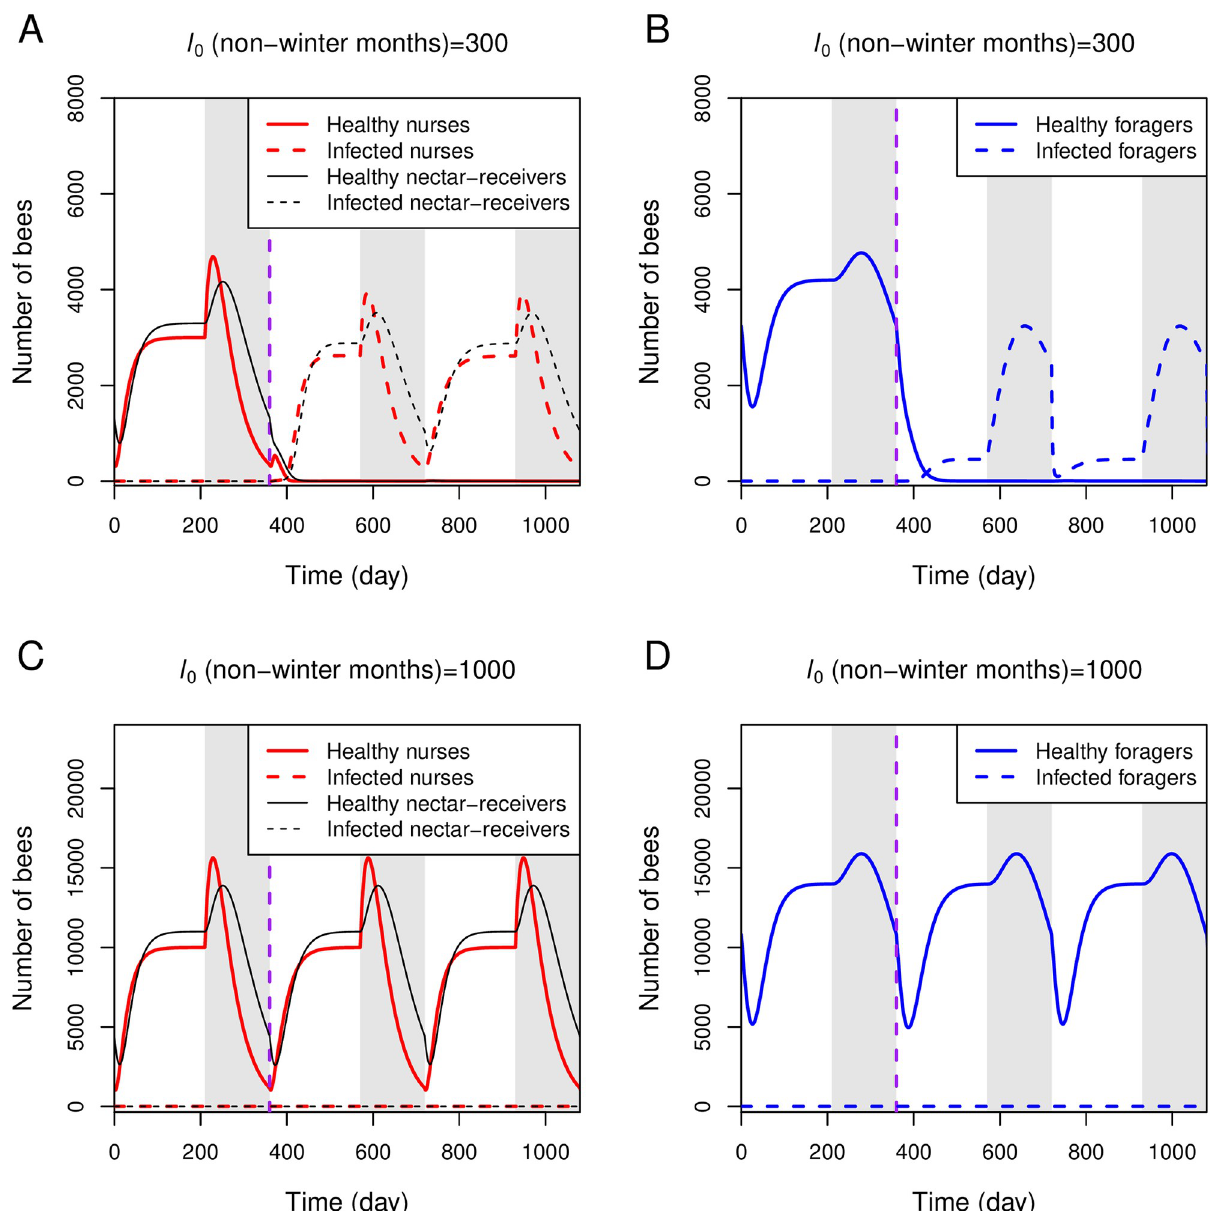
Fig 6. Simulations of the full model under seasonal effects. The full model is simulated with parameters listed in Table 1 under seasonal effects. During winter (grey stripes), which lasts five months a year, we set l 0 = 0, k r = 0, and n N , n R , and n F are increased 4-folds. A and B: l 0 during non-winter months = 300. C and D: l 0 during non-winter months = 1000. One infected forager returning from nectar-collecting (iF 1 ) is introduced at day 360 (vertical purple line).